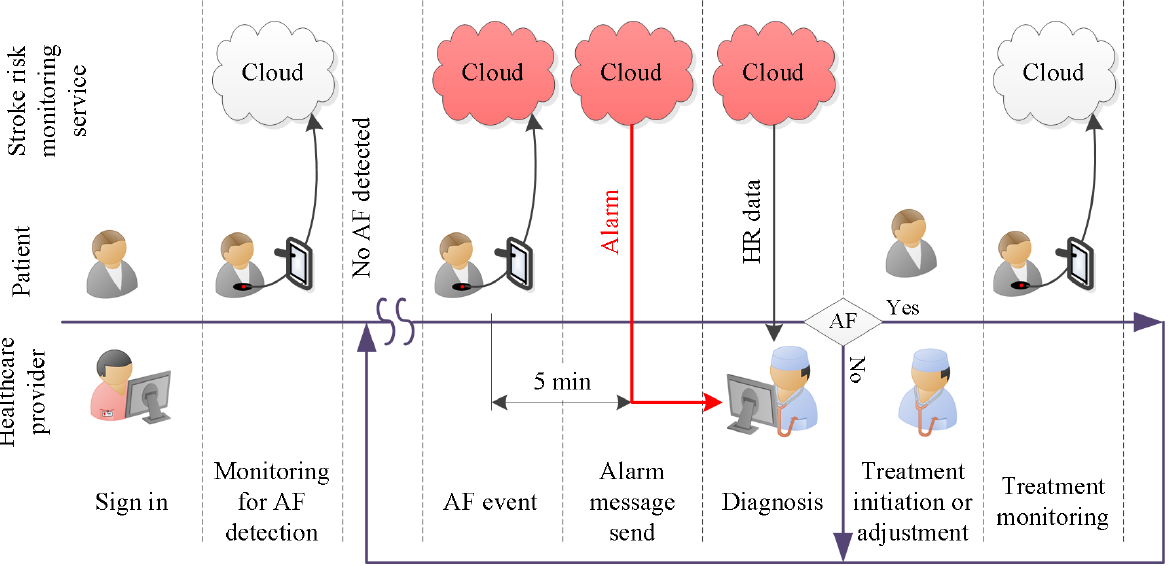
Figure 1. Required service functionality over